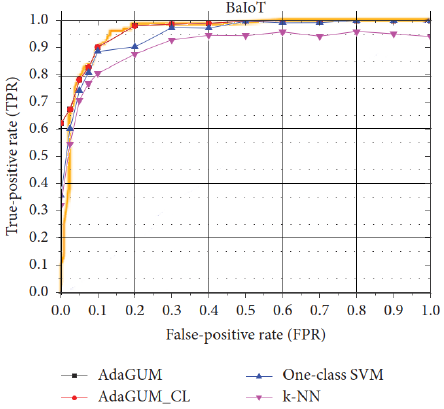
Figure 1. Comparison of ROC curves from [44,52]. Table 9. Performance of surveyed works for malicious attack application. An * indicates averaged